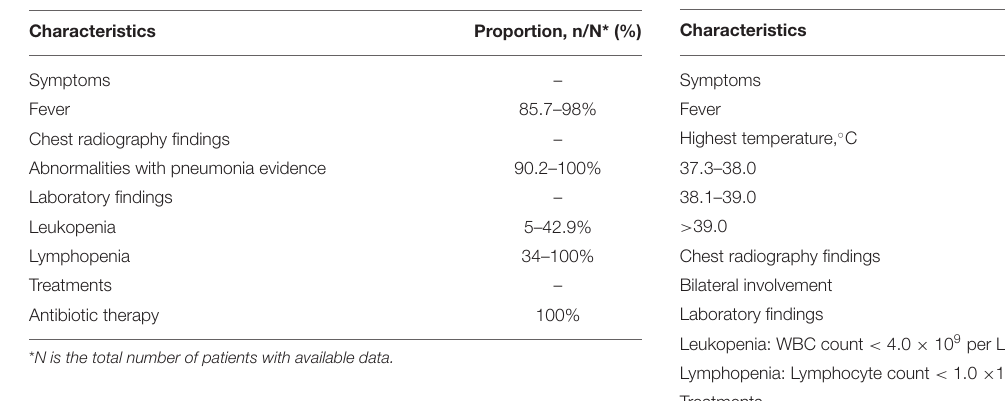
TABLE 4 | Characteristics summary of early COVID-19 patients according to the surveillance guideline for pneumonia with uncertain etiologies, from December